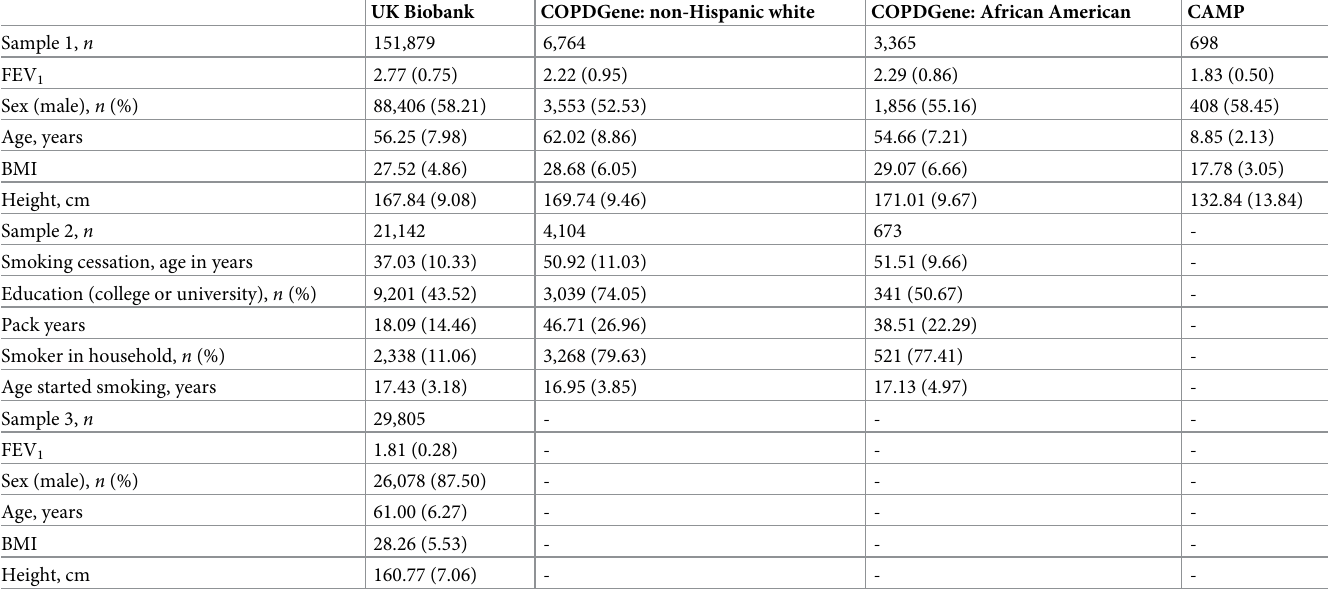
Table 1. Characteristics of subjects from the UK Biobank, COPDGene, and CAMP data. For continuous variables, we give the mean and standard deviation (i.e. mean (sd)). Sample 1 is for FEV 1 as the outcome. Sample 2 is for age at smoking cessation as the outcome and includes former smokers. Sample 3 is for FEV 1 as the outcome for the subjects with the lowest 20% of FEV 1 .